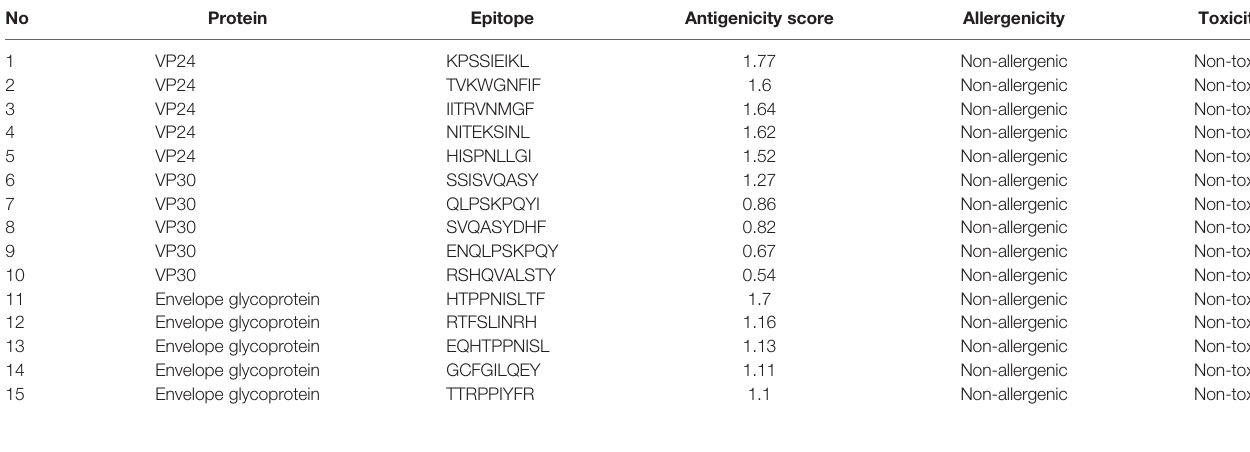
TABLE 2 | Top-ranked T-cell epitopes (MHC-I peptides) of VP24, VP30, and envelope